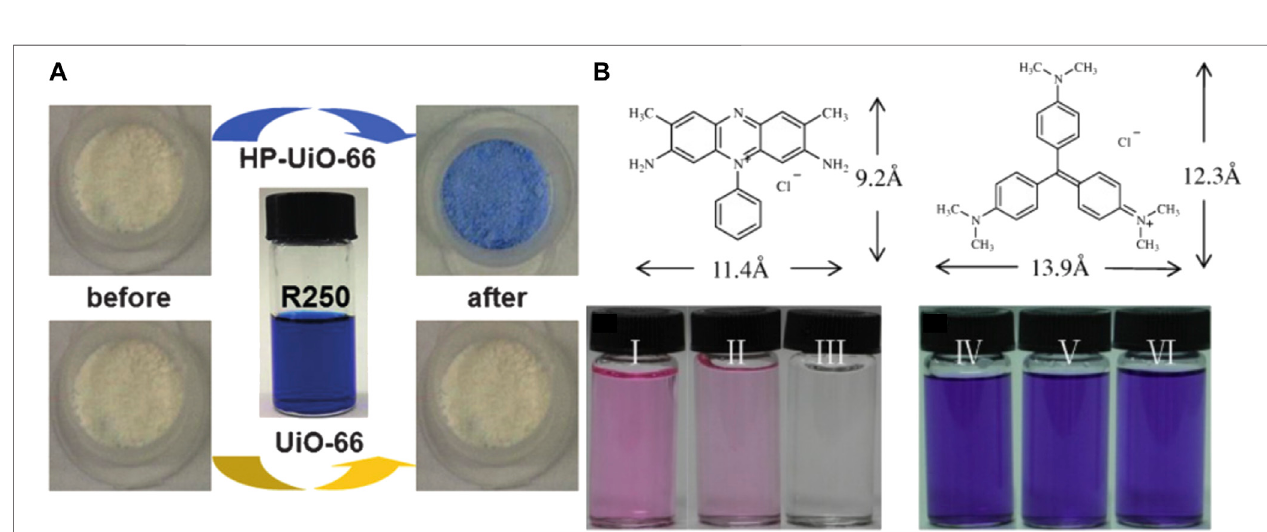
FIGURE 8 | (A) Color of the powder sample of UiO ‒ 66 and HP ‒ UiO ‒ 66 before and after dye adsorption (Cai and Jiang, 2017) and (B) photographs of ST and CV before and after adsorption process by defect free UiO ‒ 66 (UiO ‒ 66 ‒ ND) and defective UiO ‒ 66 (UiO ‒ 66 ‒ 15) (Wang et al., 2016).